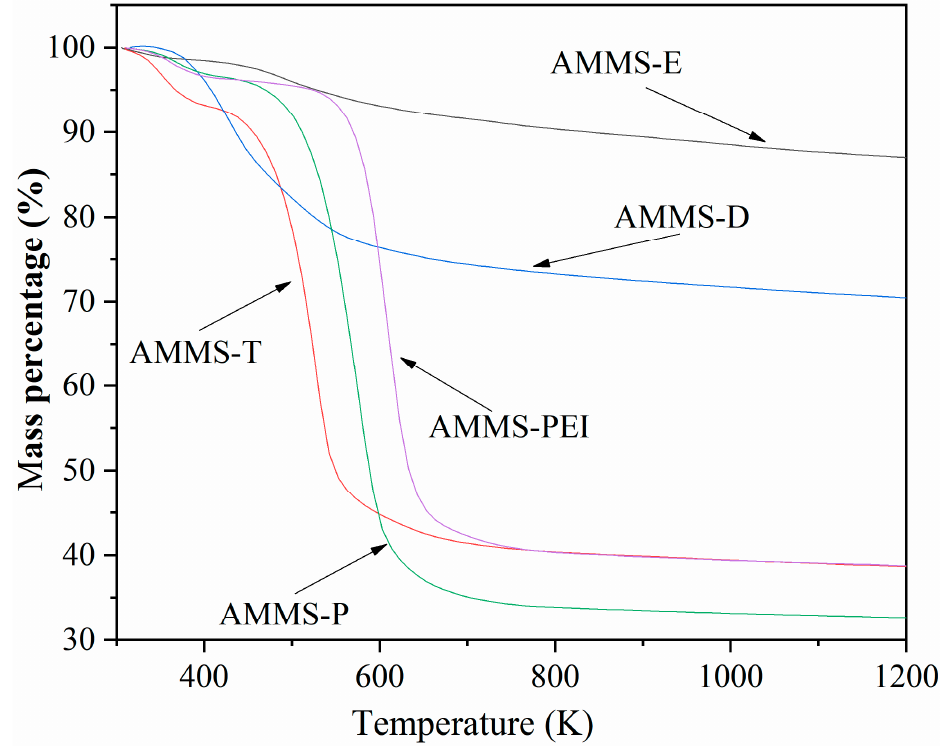
Figure 4. TGA results of